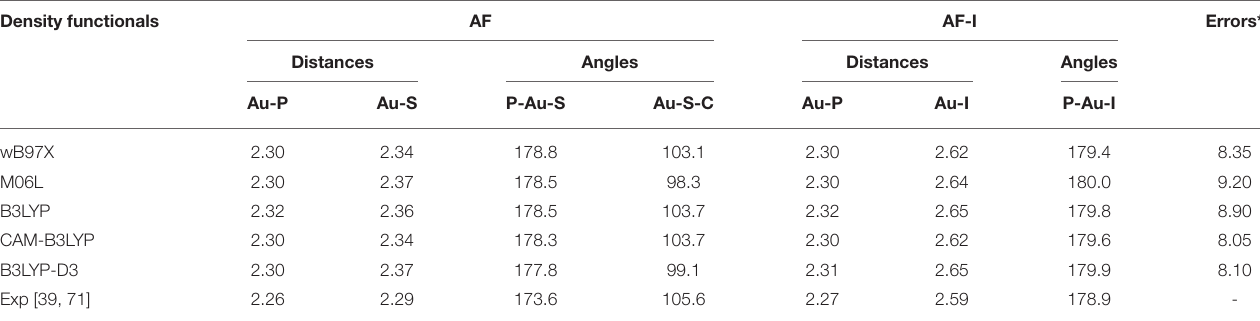
TABLE 2 | Assessment of five density functionals for the geometry optimization via comparison of experimental and calculated values for structural parameters of AF and AF-I complexes ( Figure 1 ). Density functionals AF AF-I Errors* Distances Angles Distances Angles Au-P Au-S P-Au-S Au-S-C Au-P Au-I P-Au-I wB97X